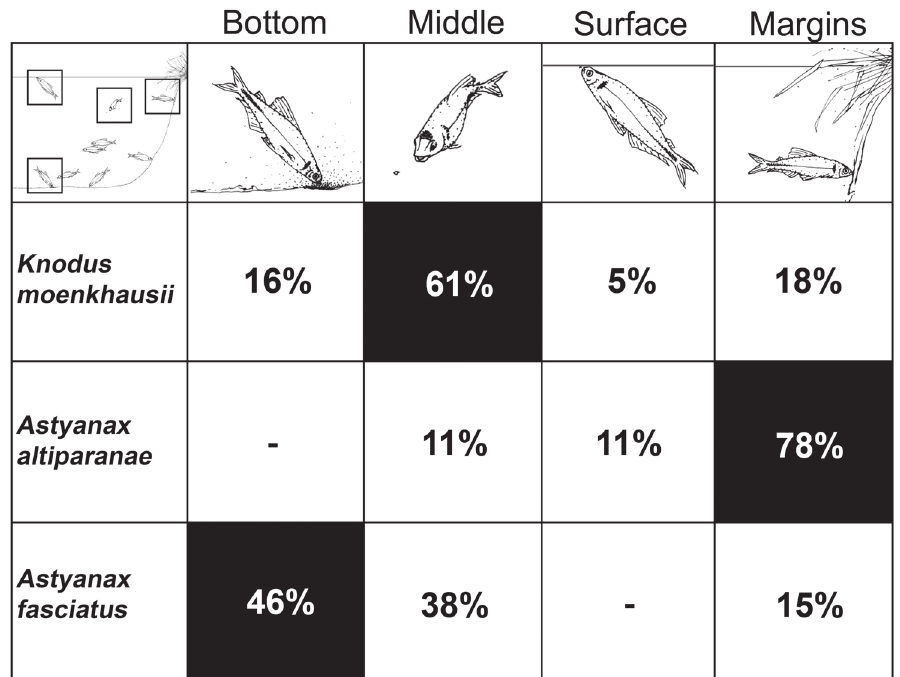
Figure 4. Foraging microhabitats in the water column and habitat use percentages, suggesting spatial segregation among three nek- tonic species.